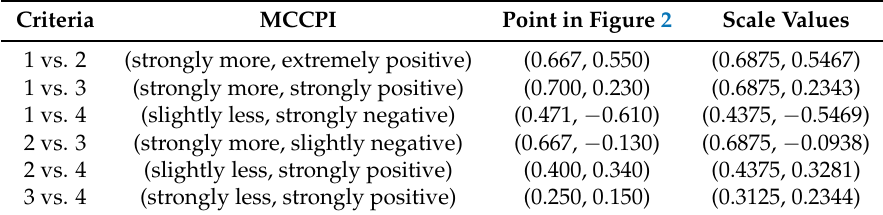
Table 4. The MCCPI and representative values.